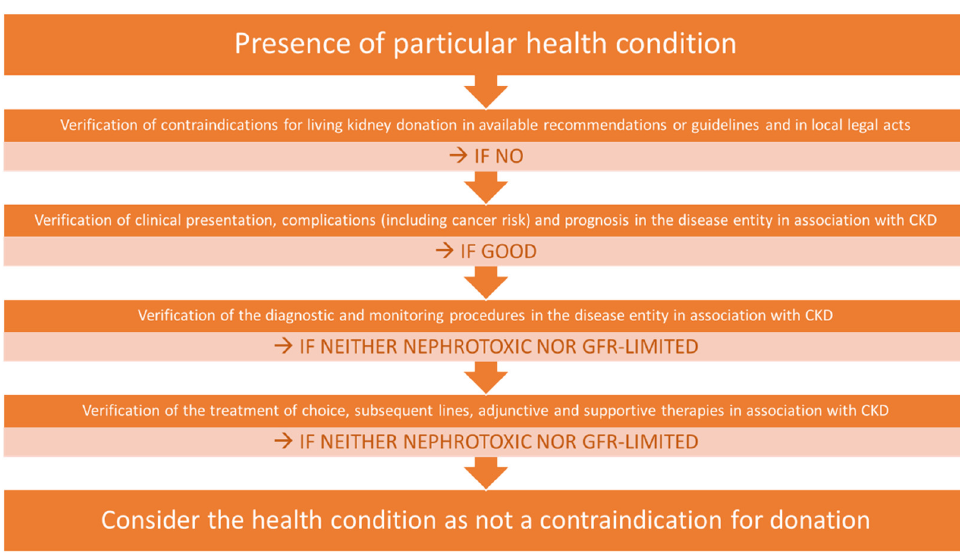
Figure 2. The decision-making flowchart for the living donor suitability assessment. Each step contains two possible answers. Continue if the assumption from every second (brighter) line is met.